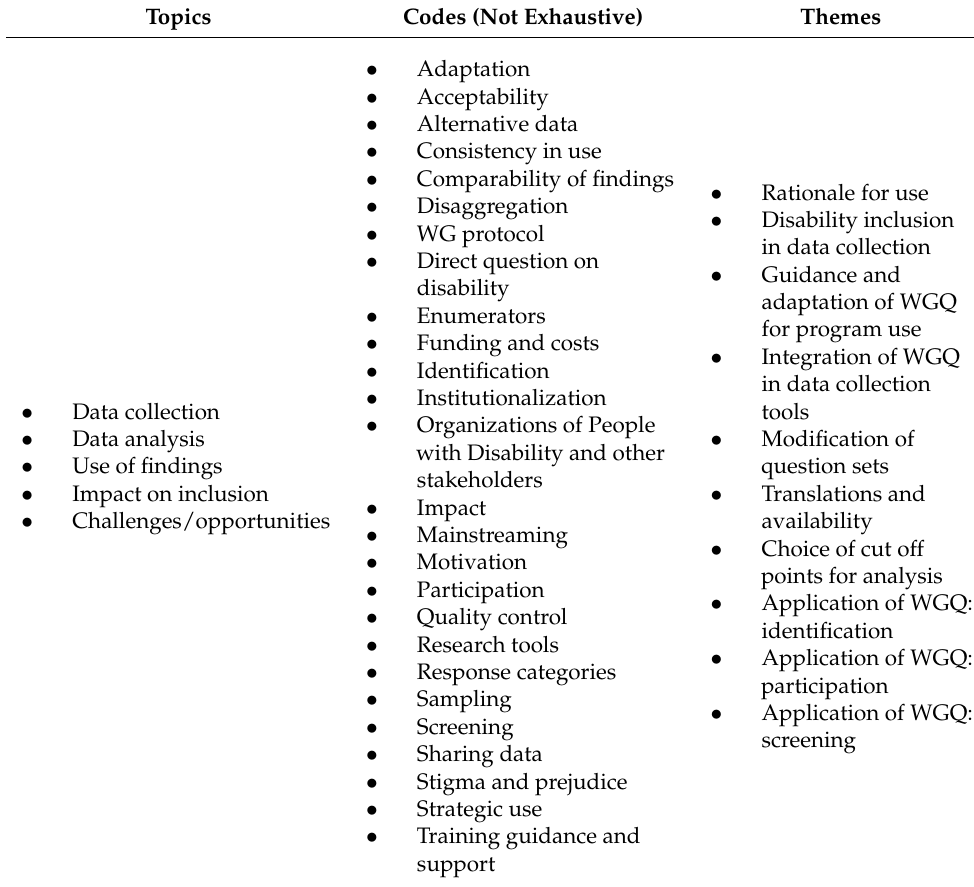
Table 1. Overview of interview topics, codes, and